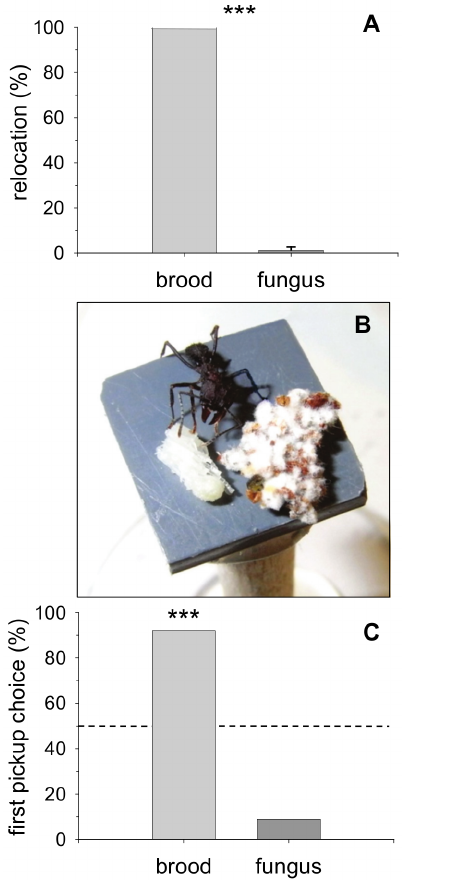
Figure 2. Brood and fungus relocation experiments. (a) Experiment 1: Relocation of items from cold stress (10 u C) by a worker group after 24 h, presented as percentage of the total offered amount (20 pupae and 0.5 g fungus) (median 6 25–75% percentiles), ***p , 0.001 (Analysis of colony effects: Kruskal-Wallis-Test; Brood relocation; H=0.0; p=1; n=5; Fungus relocation; H=0.66; p=0.72; n=5; n.s.; no colony effects found). (b) Experiment 2: Relocation of items from desiccation by single workers: an A. lundi worker encounters a pupa and a piece of fungus on an experimental platform (1.5 6 1.5 cm). (c) Score of first item relocated, expressed as percentage of total observations